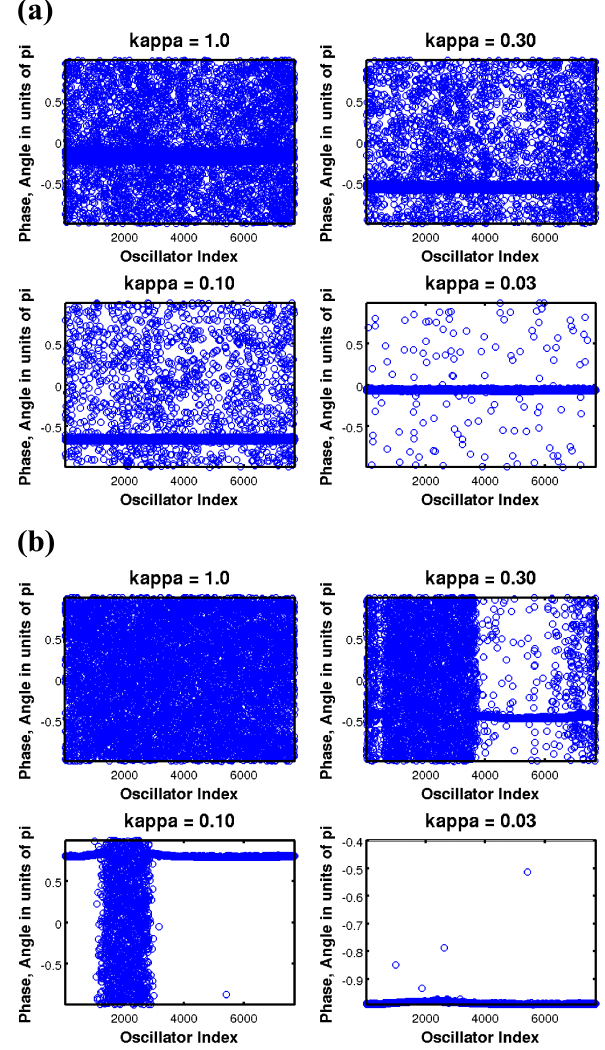
Figure 10. (a) Effect of the non-local coupling coefficient param- eter, κ , on the evolution and disappearance of the chimera states for the 128 × 128 grid without recurrence. Stationary phase angle as a function of the oscillator index: kappa, κ = 1.0 (top left panel); kappa, κ = 0.3 (top right panel); kappa, κ = 0.1 (bottom left panel); kappa, κ = 0.03 (bottom right panel). (b) Effect of the non-local coupling coefficient parameter, κ , on evolution and disappearance of the chimera states for the 128 × 128 grid with recurrence. Sta- tionary phase angle as a function of the oscillator index: kappa, κ = 1.0 (top left panel); kappa, κ = 0.3 (top right panel); kappa, κ = 0.1 (bottom left panel); kappa, κ = 0.03 (bottom right panel).